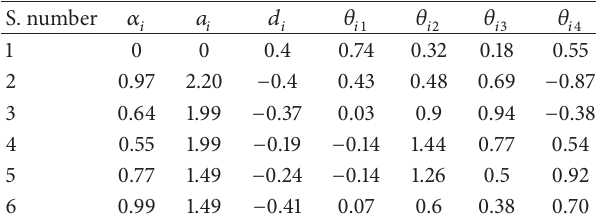
Table 1: Six-link manipulator